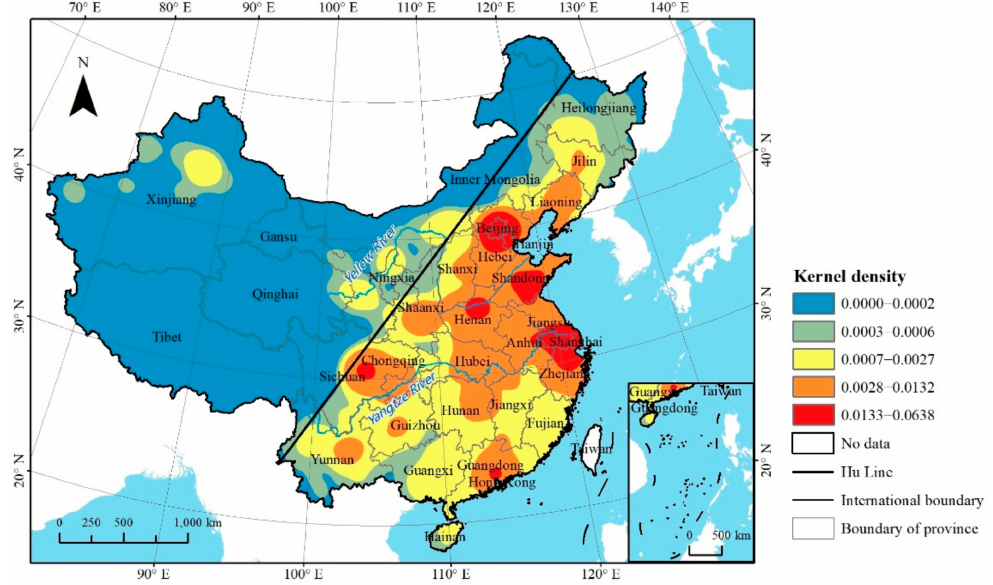
Figure 3. Kernel density estimation of picking orchards in China (density surface based on the picking orchard points is displayed from blue to red representing the density from low to